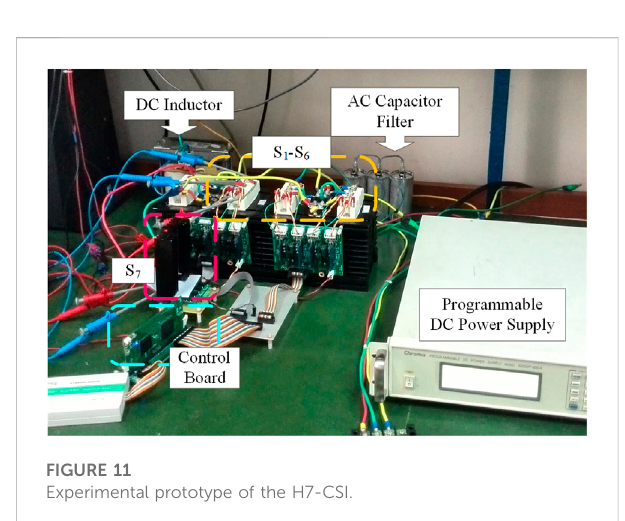
FIGURE 11 Experimental prototype of the H7-CSI.